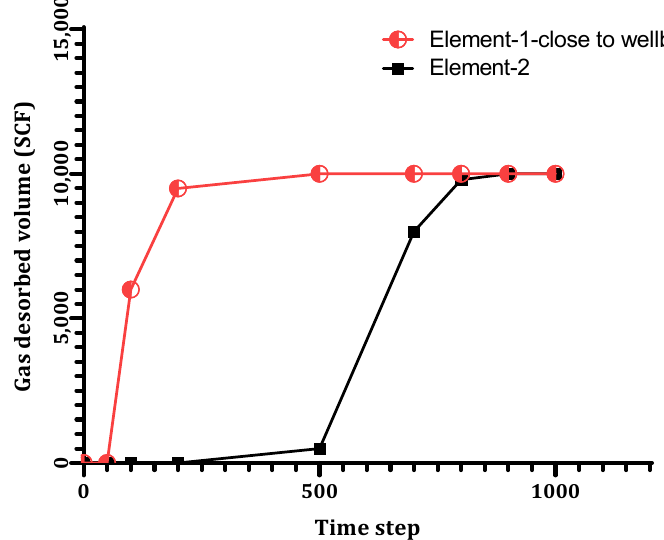
Figure 10. Gas desorbed volume for two elements used in the simulation model. A sensitivity study was performed to test the effect of the fracture length on the gas production rates. The fracture lengths used were 20 ft and 60 ft. Figure 11 shows the production profile in both cases (with fracture lengths of 20 and 60 ft). It can be seen from Figure 11 that a low production rate profile with fracture length = 20 ft occurred. In addition, the critical desorption pressure is achieved at a later stage for fracture with a length = 60 ft. It can be observed from Figure 11 that the gas production rate is sustained for a long period during the production process with a fracture length = 60 ft. Moreover, it can be observed from Figure 11 that the gas production rate declines 20–35% per month at the beginning of the production process and then the declining rate stabilizes at around 7% after 2 years of production (100-time step) which is a typical scenario for unconventional reservoirs.